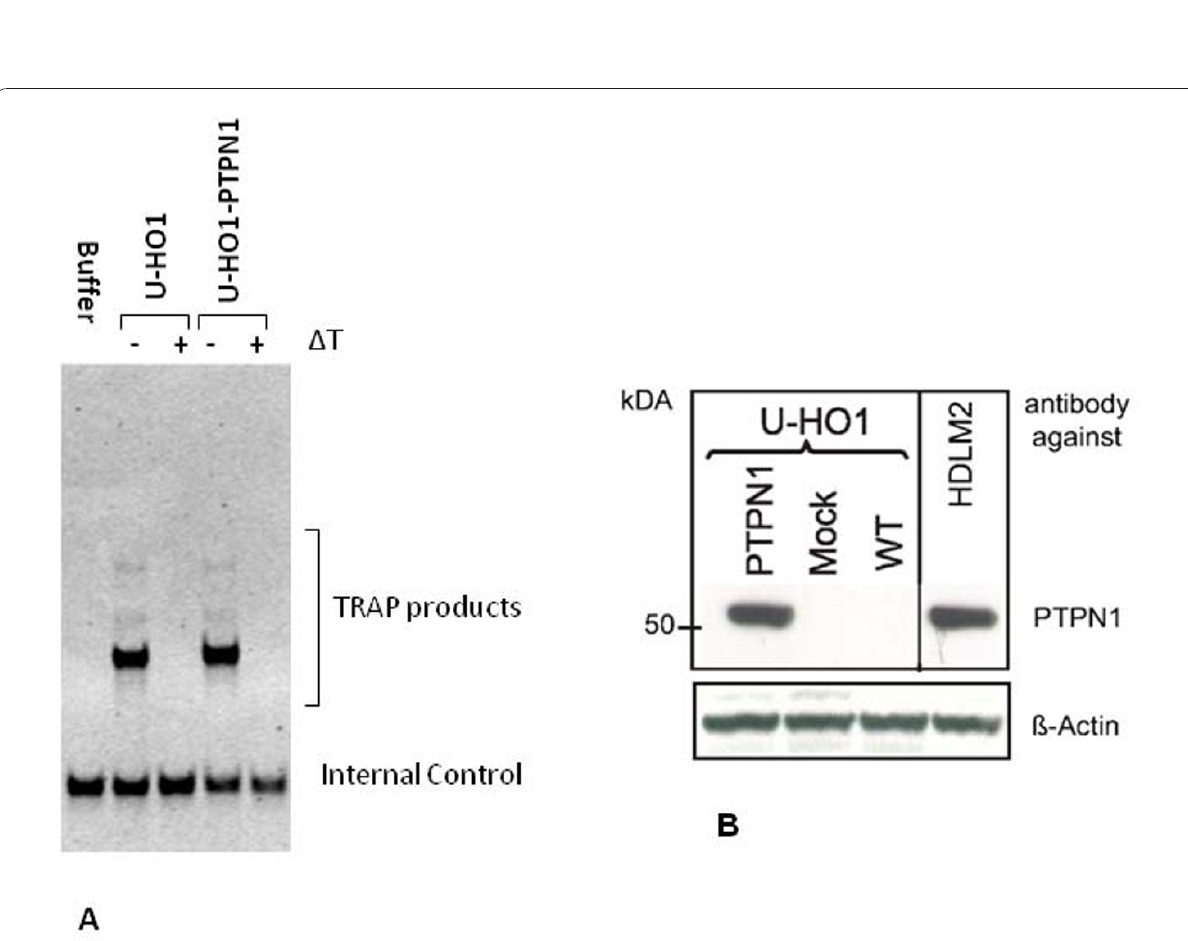
Figure 2 Telomerase activity and stable PTPN1 expression . A. TRAP assay shows equal telomerase activity in the HD-cell lines U-HO1 and U-HO1-PTPN. Internal control of each sample after heat denaturation ( Δ T +) demonstrates specificity. B. A strong specific band near 50 kDA is observed in U-HO1-PTPN1 and in the positive control, the HD-cell line HDLM-2, whereas no signal is detected U-HO1 and